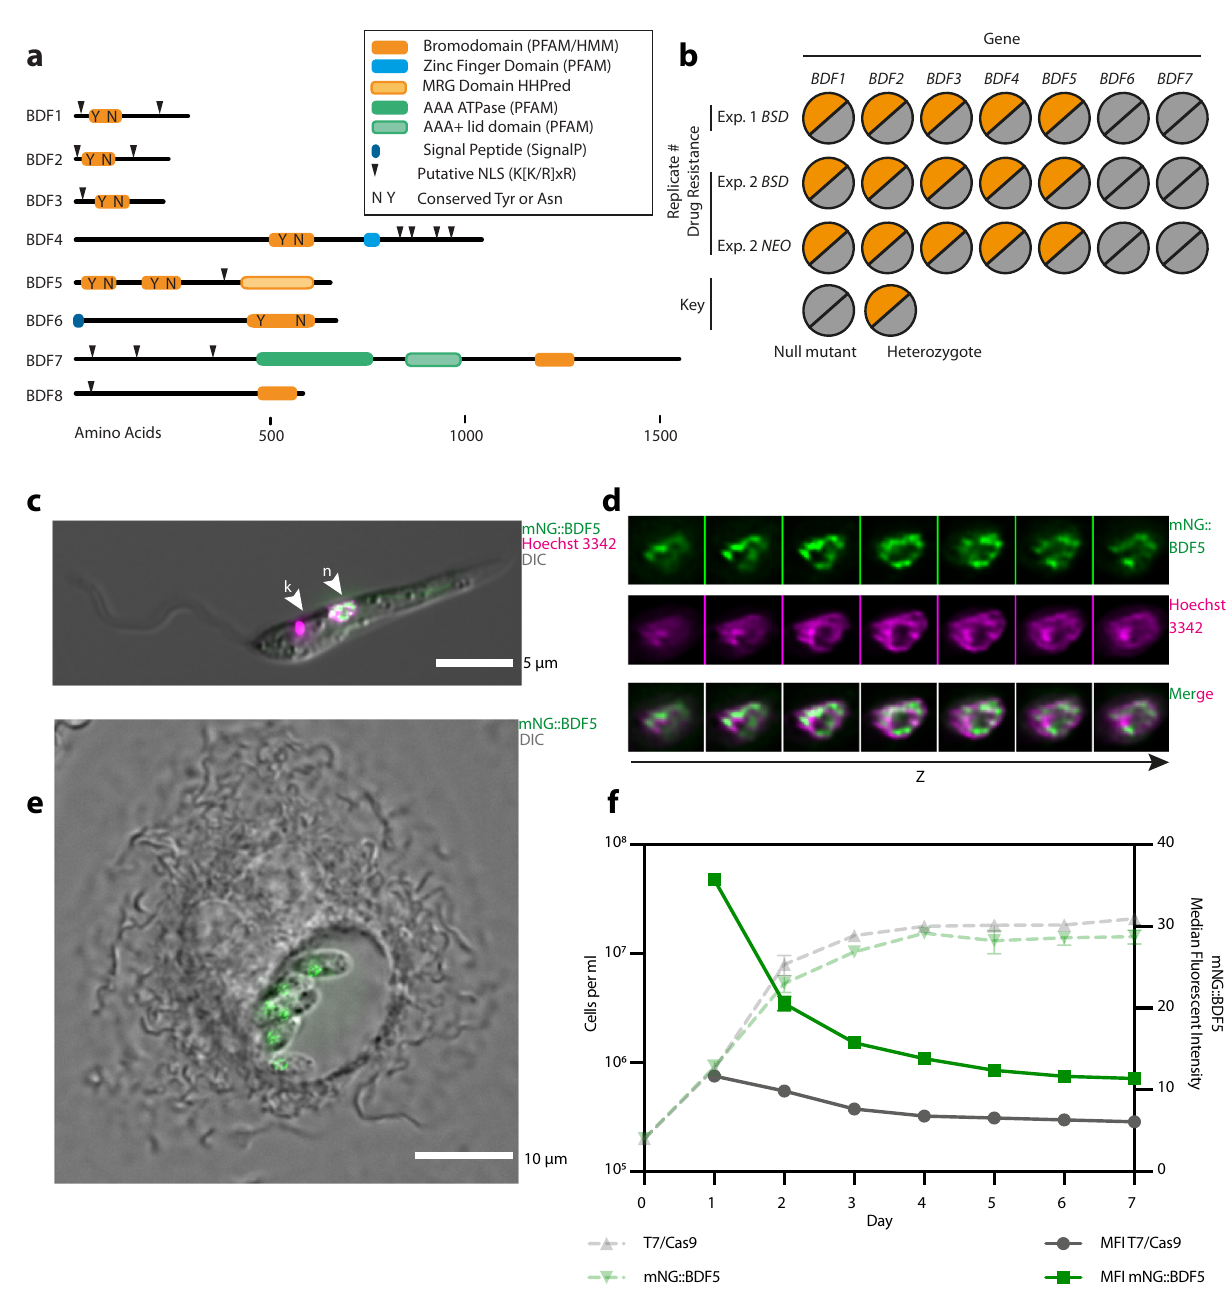
Fig. 1 Overview of putative Leishmania bromodomain factors. a Schematic showing protein domain architecture of Leishmania BDFs. b Overview of Cas9 gene deletion attempts of BDF1 – 7 in L. mexicana T7/Cas9 promastigotes. Two independent transfections were carried out, one using only BSD , another using both BSD or NEO as a drug selectable markers. For the BSD plus NEO experiment clones were selected using blasticidin and G418 in combination, or individually. No clones were recovered from the dual selection, but null mutants of BDF6 and BDF7 were recovered on all 3 occasions when a single drug selection was applied. No null mutants of BDF1 – 5 were ever recovered. c Live-cell fl uorescent microscopy of L. mexicana promastigote expressing mNG::BDF5. Nucleus is denoted by arrowhead labelled n, the kinetoplastid DNA is indicated by arrowhead labelled k. d Channel separated Z-slices of the nucleus from the cell in ( c ). e Live-cell fl uorescent microscopy of intramacrophage L. mexicana amastigotes expressing mNG::BDF5 endogenously tagged protein. f Expression levels of mNG::BDF5 during promastigote growth, determined by mNG signal in individual cells by fl ow cytometry. Dashed points denote mean cell density, error bars ± standard deviation, solid points denote median fl uorescence intensity, N = 3,20,000 events per investigate BDF5 in greater detail. BDF5 homologs are identi fi - X-ray crystal structures available in the PDB (PDB ID: 5TCM, able in all the kinetoplastid genomes available in TriTrypDB. The 5TCK), verifying the bromodomain structural fold and con fi rm- level of amino acid conservation across the fi rst bromodomain ing the positions of the conserved residues (Supplementary (BD5.1) is higher than the second (BD5.2), but in all cases the Fig. 2b). BDF5 was endogenously tagged using a Cas9-targeted conserved tyrosine and asparagine residues are retained in both approach to append a 3xMyc epitope and the green fl uorescent bromodomains (Supplementary Fig. 2a), these correspond to Y40, protein mNeonGreen to the N-terminus 32 to generate N90, Y201 and N247 in LmxBDF5. Both bromodomains have